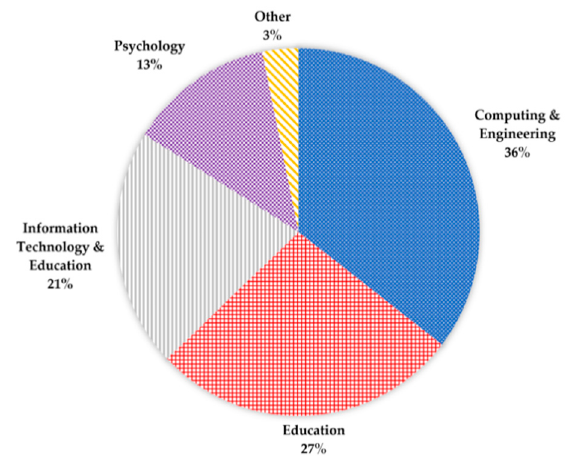
Figure 4. Category of publication venues.